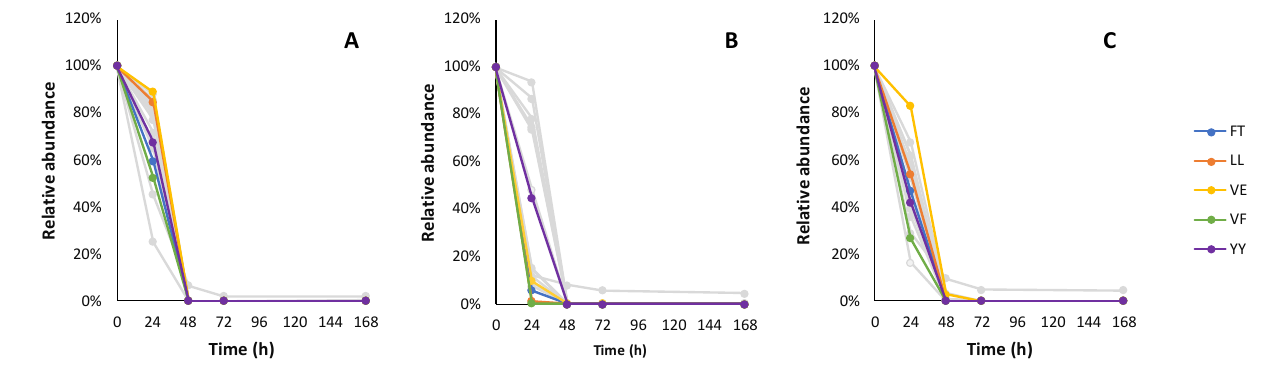
Figure 2. The optical density (OD) and CO 2 production rate in fermentations with Lalvin ICV Opale 2.0™, Lalvin Persy™ and Lalvin QA23™ of the modified synthetic must with (solid line) and without (dashed line) added BSA hydrolysate as the peptide source.